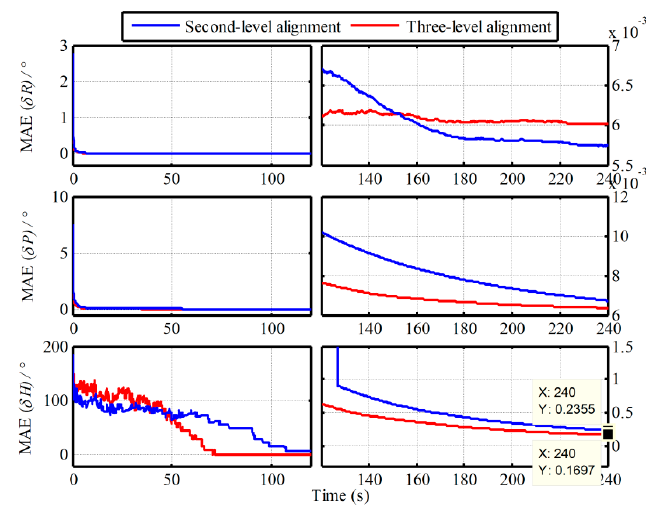
Figure 7. MAE curves of alignment results with the proposed algorithm.